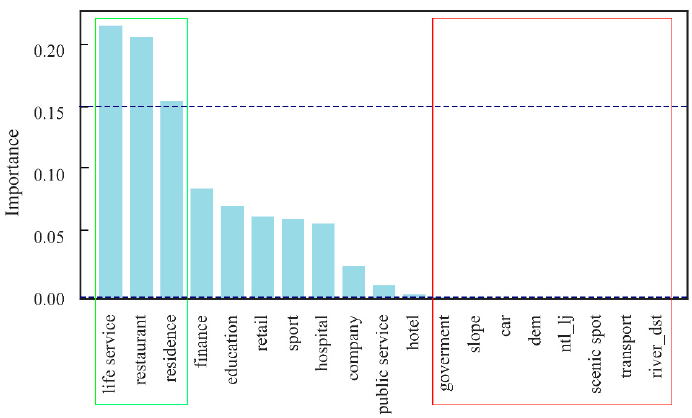
Figure 8. Feature importance for the random forest regression model.